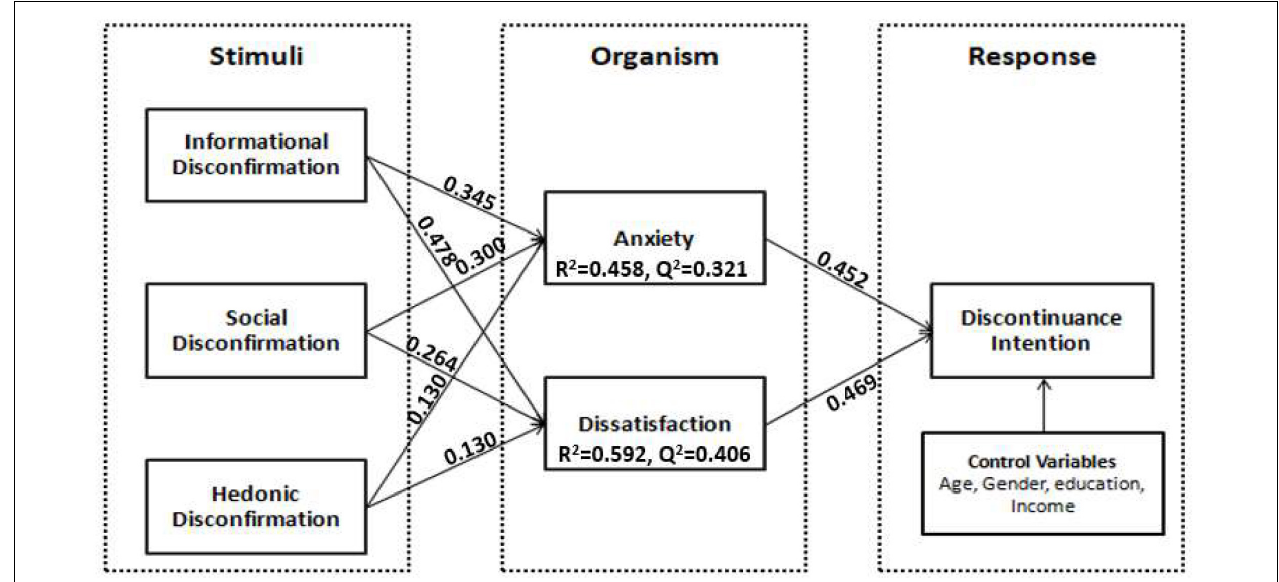
FIGURE 2 | Presents the path coefficients of the structural model.